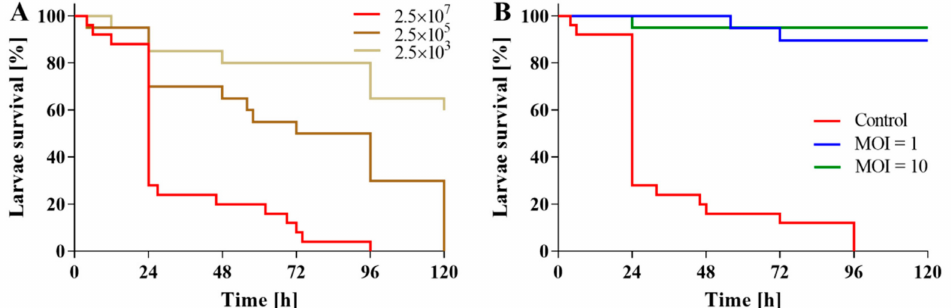
Figure 7. Lethality of honeycomb moth larvae. ( A ) Influence of B. bronchiseptica cell number on larvae survivability. Twenty-fivelarvaepergroupandthreegroups(2.5 × 10 3 , 2.5 × 10 5 , and2.5 × 10 7 CFU / larva) were analyzed. ( B ) Treatment of B. bronchiseptica -infected G. mellonella larvae with BB8 phage. Control group (red line) includes Galleria larvae after treatment with B. bronchiseptica alone (approx. 2.5 × 10 7 CFU). Treatment with phage BB8 almost completely abolished the lethality of the infection at MOIs of 1 and 10 (blue and green line, respectively). Twenty-five larvae per group and three groups (control, MOI = 1, and MOI = 10) were analyzed. Survivability in larvae treated with bu ff er alone or with phage alone was 100% (these lines were omitted for